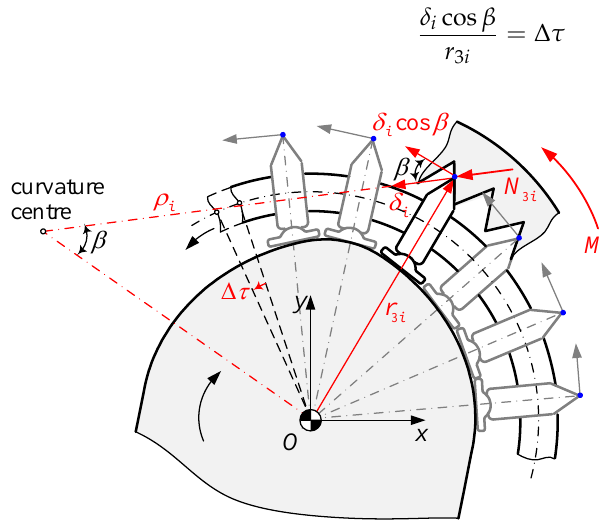
Figure 8. Force and elastic deformation at the contact point.